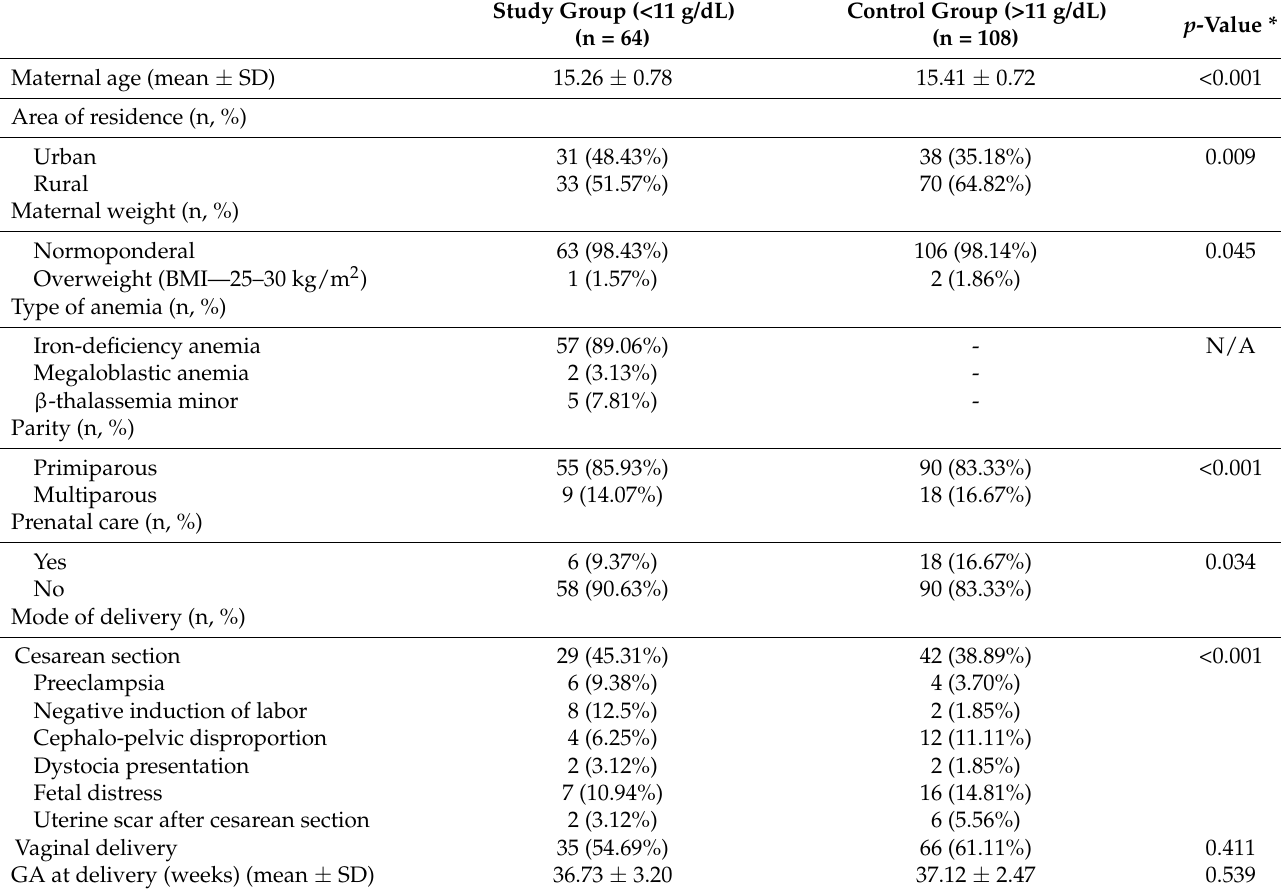
Table 1. Description of study participant group structure and